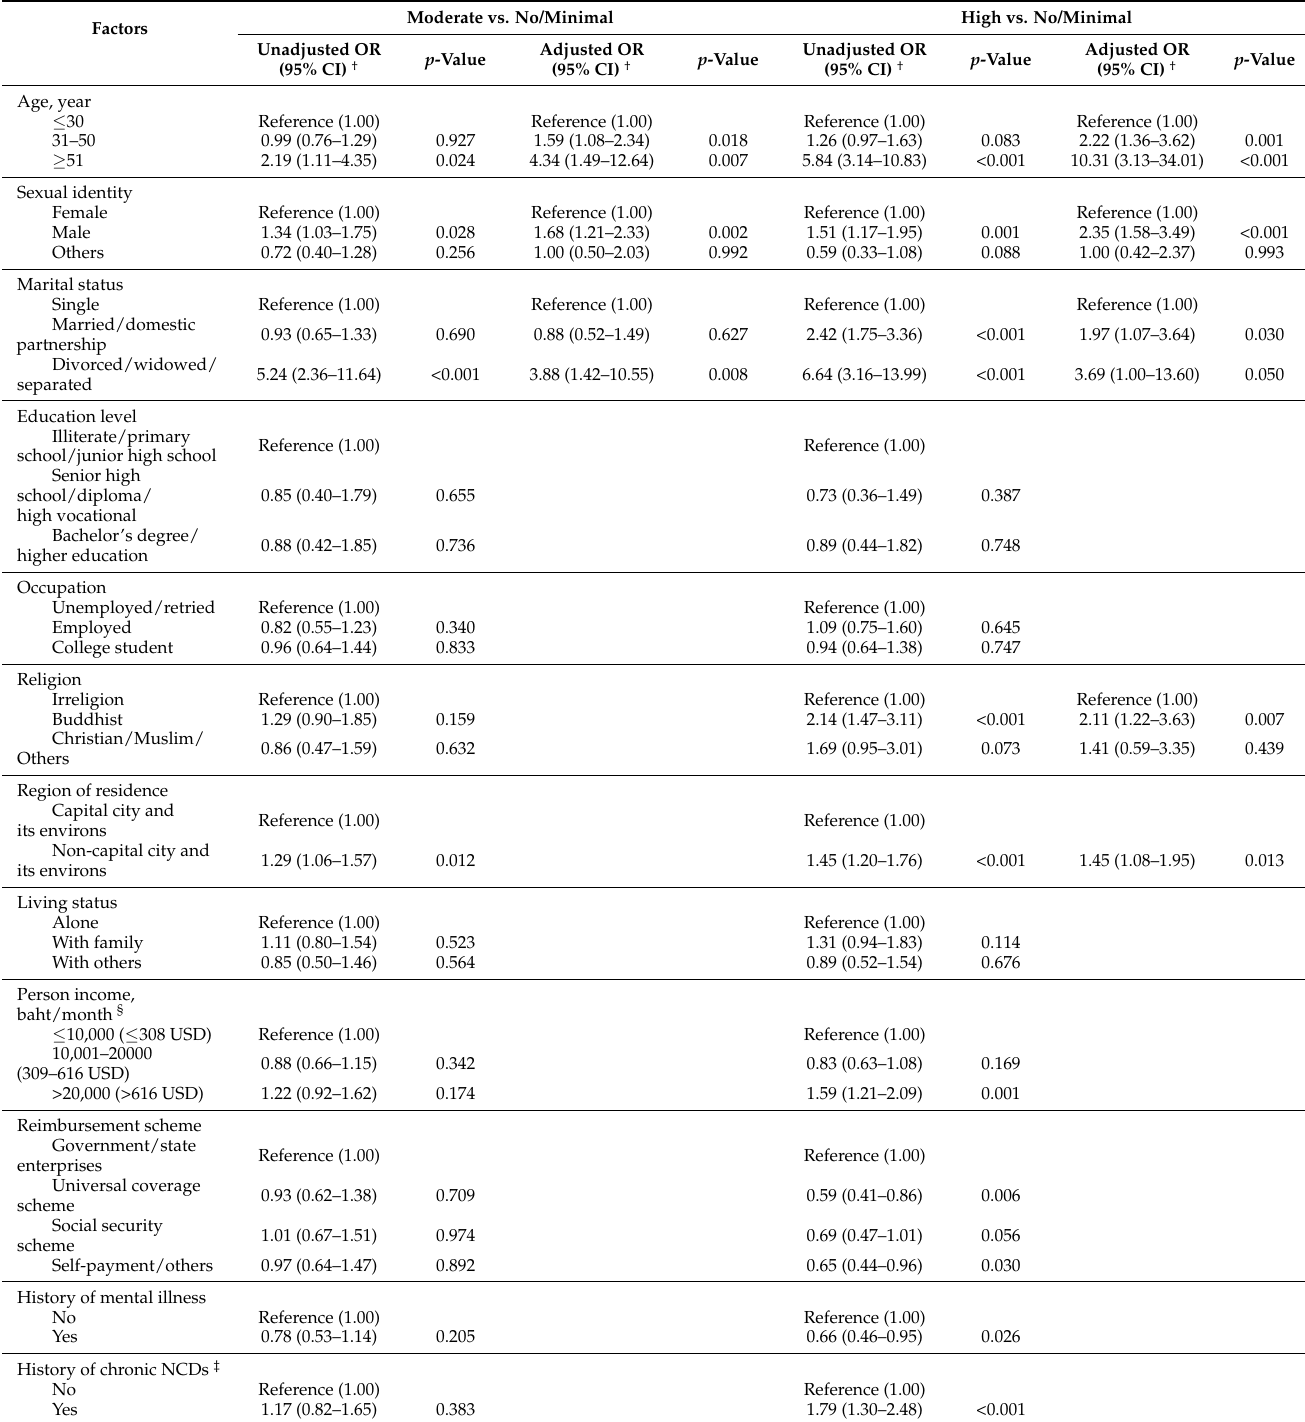
Table 2. Multinomial logistic regression model results of factors associated with COVID-19-related public stigma (n =